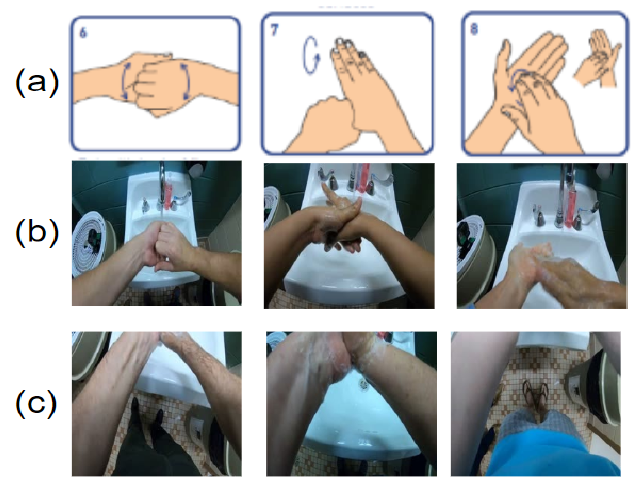
Figure 3. ( a ) Standard subtle actions between fingers. ( b ) Clear view of subtle actions. ( c ) Hands out of camera views.